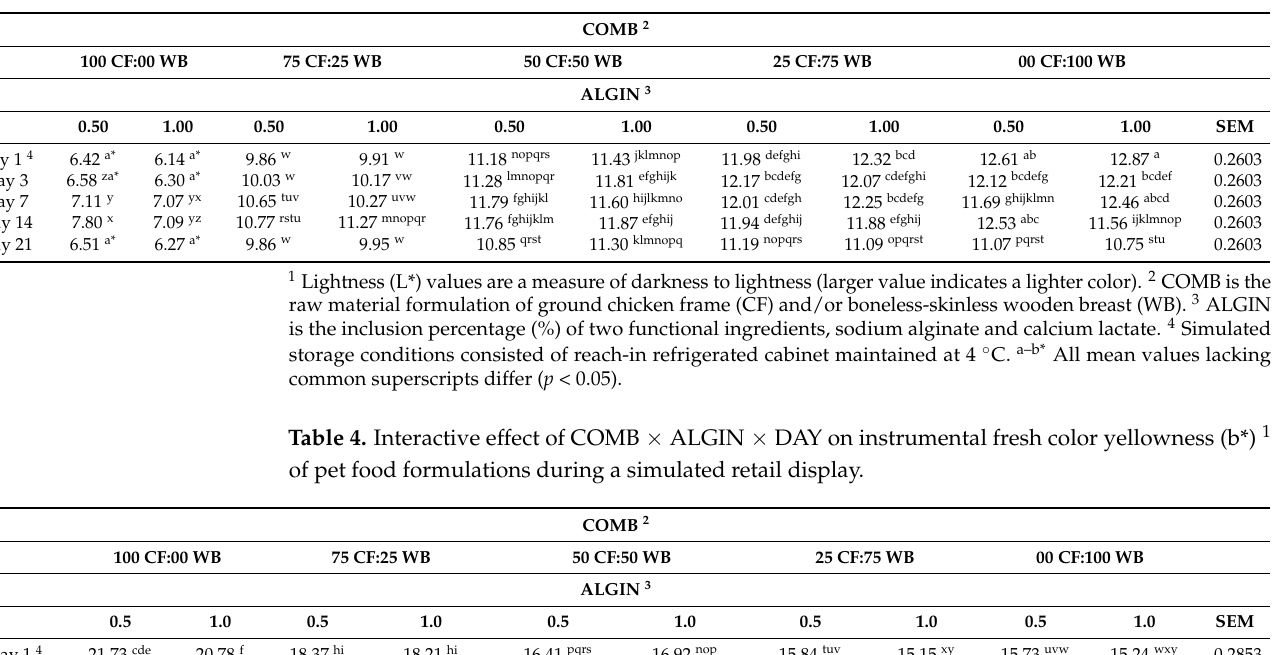
Table 3. Interactive effect of COMB × ALGIN × DAY on instrumental fresh color redness (a*) 1 of fresh 1 Lightness (L*) values are a measure of darkness to lightness (larger value indicates a lighter color).